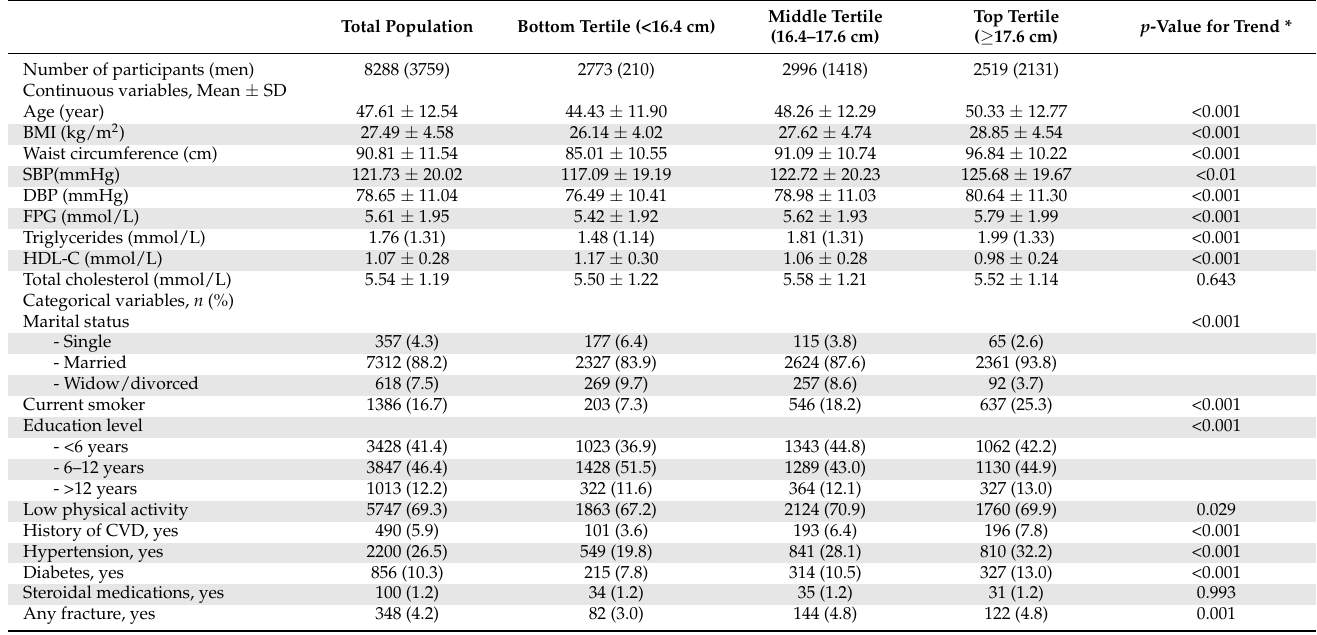
Table 1. Baseline characteristics across wrist circumference tertiles: Tehran Lipids and Glucose Study, 1999–2016. Total Population Bottom Tertile (<16.4 cm) Middle Tertile (16.4–17.6 cm) Top Tertile ( ≥ 17.6 cm)